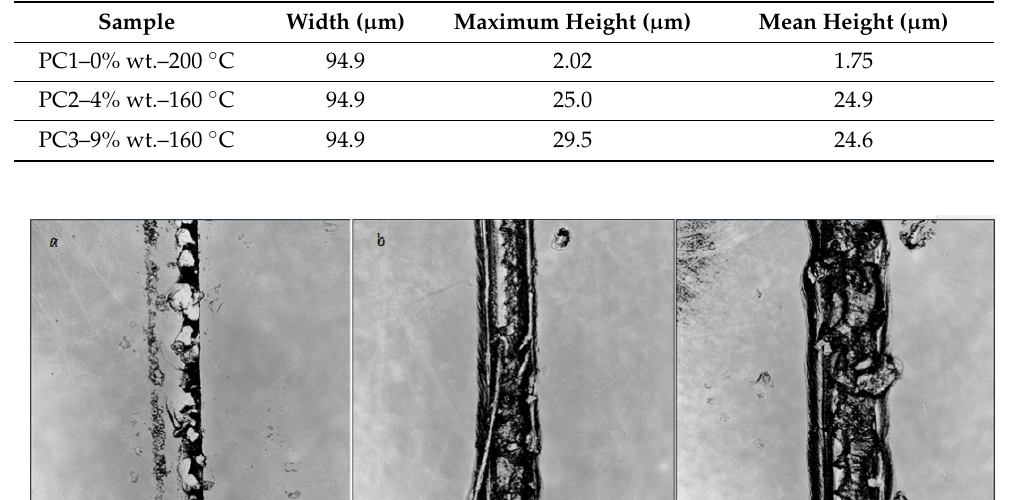
Table 4. Scratch profile for each sample measured using SCM.